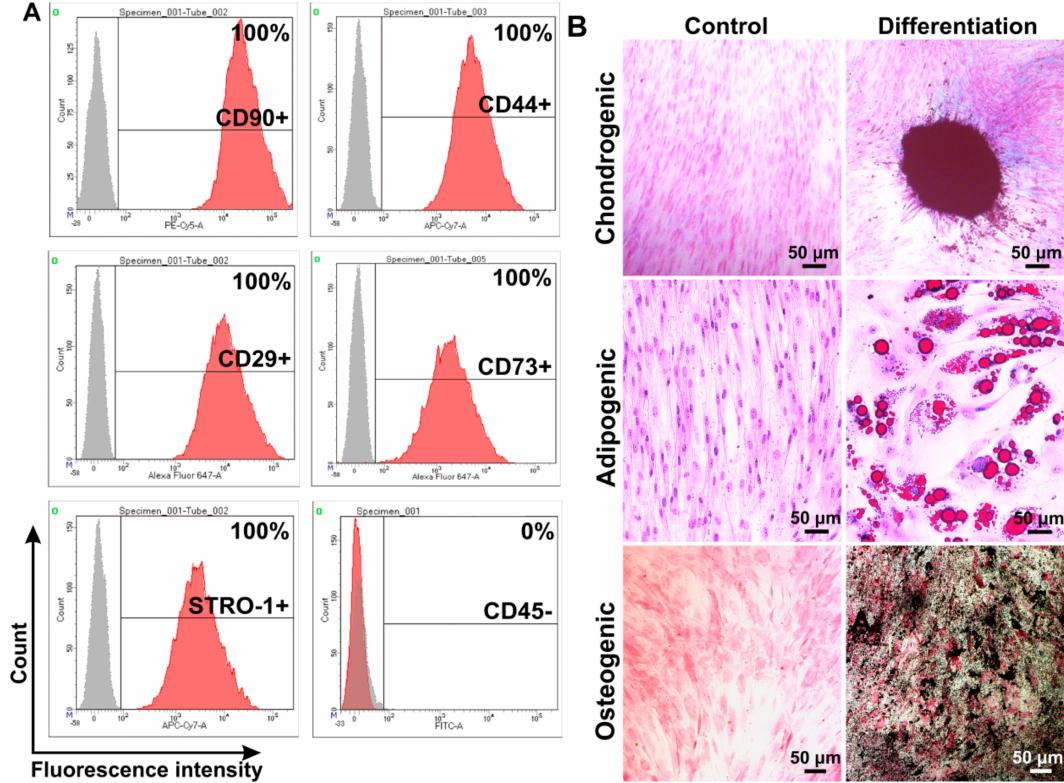
Figure 1. Phenotype analysis of human mesenchymal stem / stromal cells (MSCs) isolated